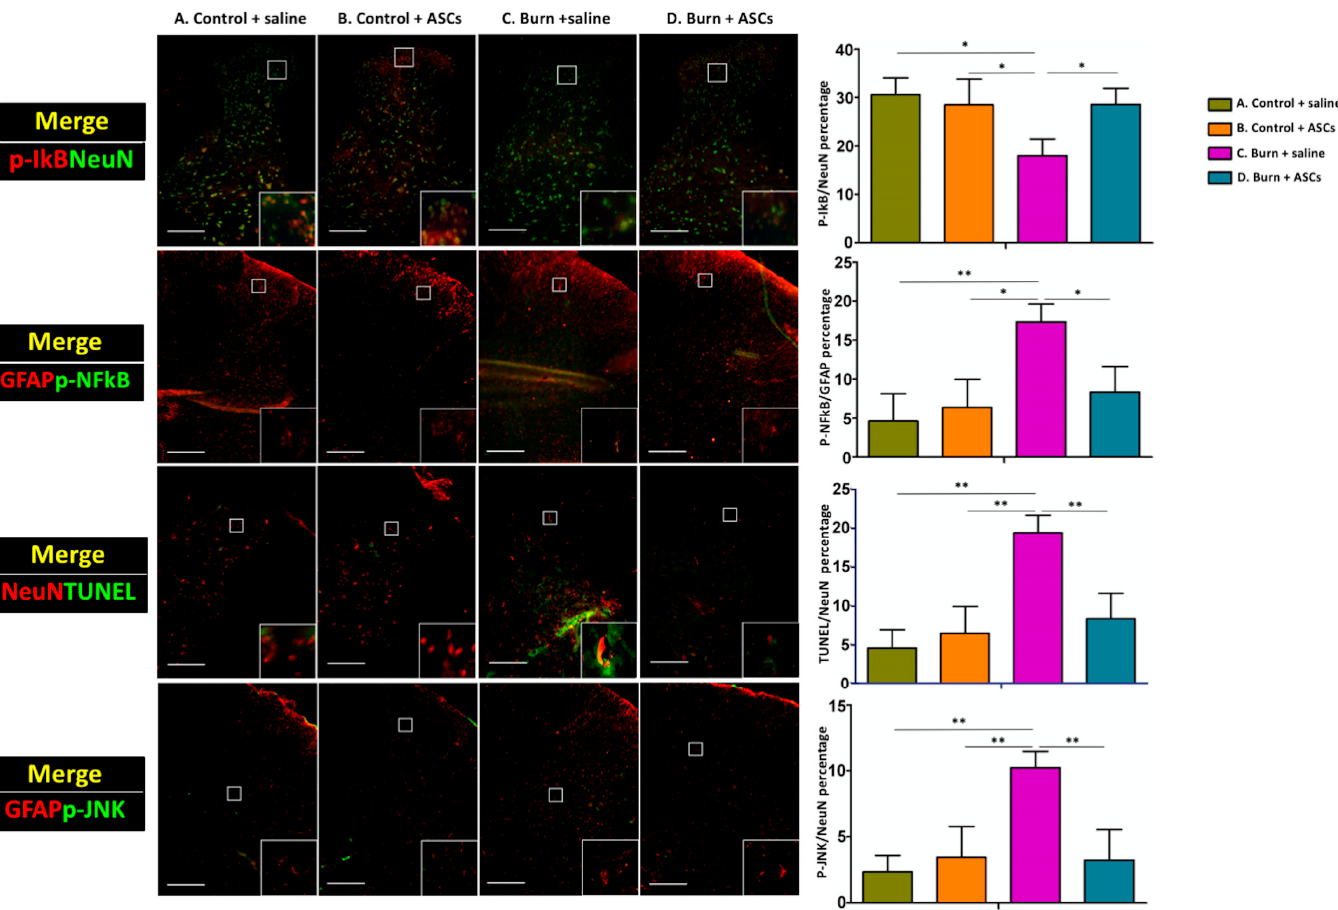
Figure 6. Ameliorated inflammation and apoptosis in the spinal cord after ASC transplantation. Four weeks after subcutaneous ASC transplantation or saline injection into burn-injured skin, quantitative immunofluorescent staining revealed a significant decrease in the total number of NeuN and p-I κ B double-positive cells and a significant increase in p-NF κ B- and p-JNK-expressing astrocytes in dorsal horn cells from Group C, compared to Groups A and D. Taken together, these results suggest that burn-induced inflammation and apoptosis in dorsal horn cells can be ameliorated by subcutaneous ASC transplantation. (** p < 0.01, * p < 0.05).